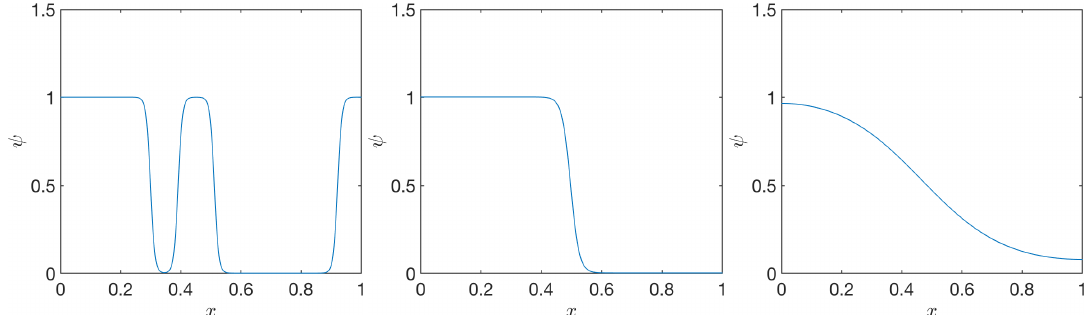
Figure A2. Solutions ψ ( x , T ∞ ) in Example A1, showing the impact of the coefficient (cid:101) . From left to right, (cid:101) = 0.005,0.01,0.1, with the corresponding T ∞ =